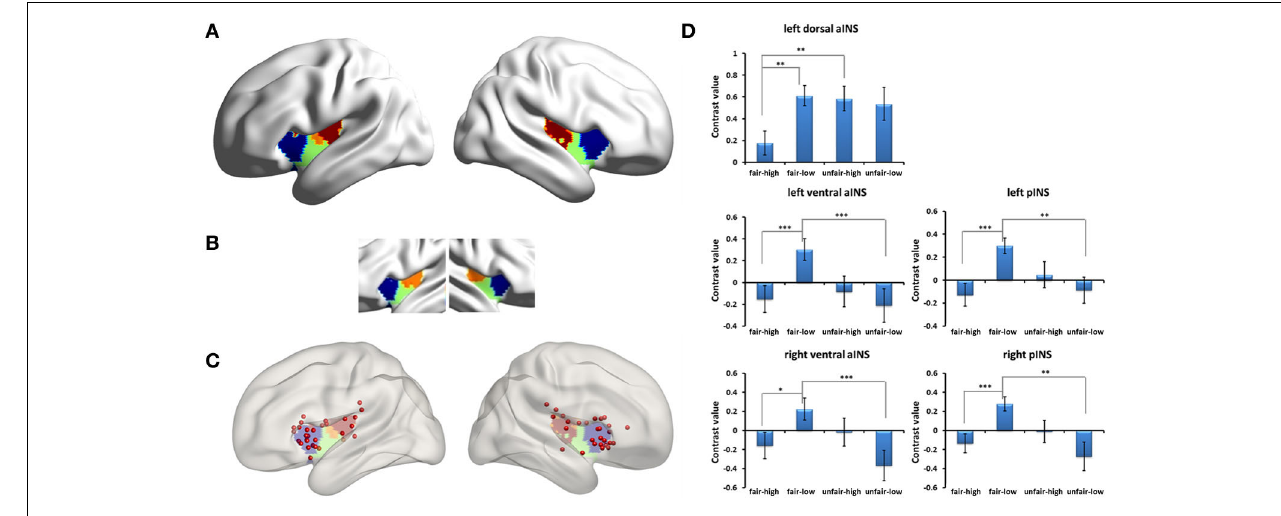
FIGURE 5 | Insular subregions influenced by the interaction of fairness and stake size for all the proposals. (A) Insular subregions intersected by Kelly’s template. (B) Kelly’s insular subregions template ( k = 3 solutions). (C) Locations of the reported insular clusters on Kelly’s template. For each